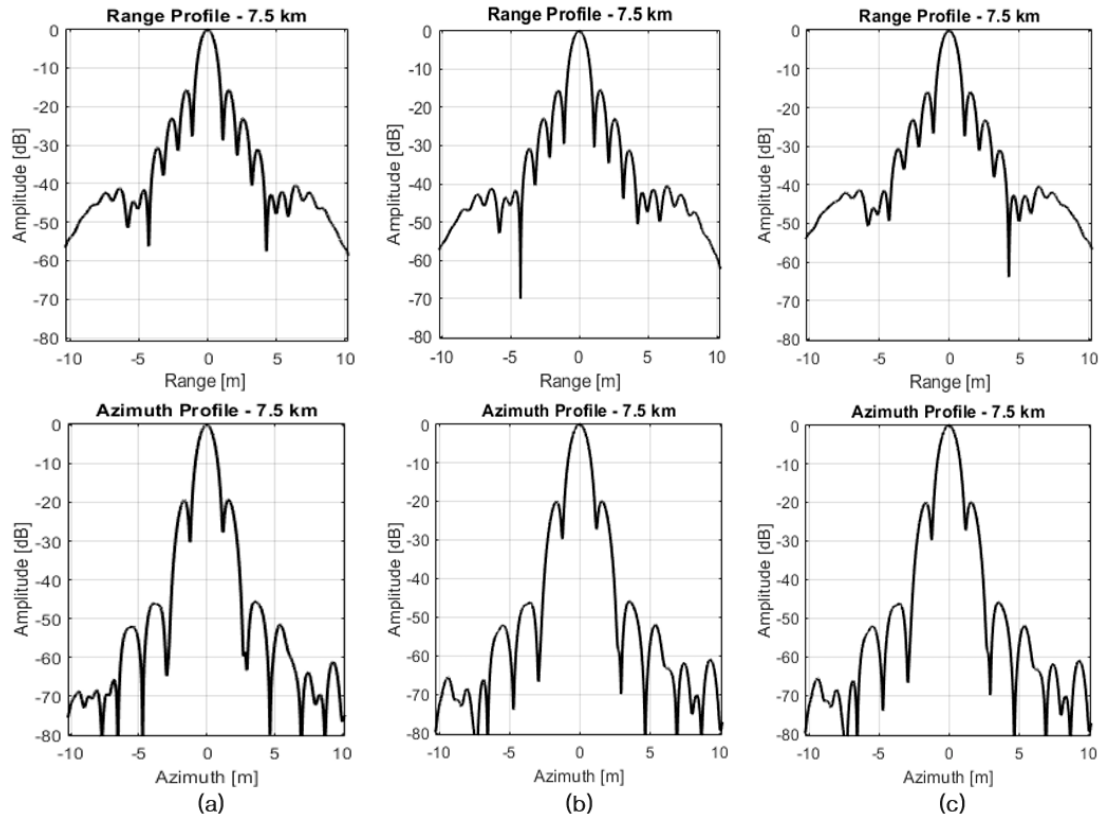
Figure 24. Range profile ( top ) and azimuth profile ( bottom ) with respect to the relative orbit determination error, 0.1 m ( a ), 0.5 m ( b ), and 1.0 m ( c ).